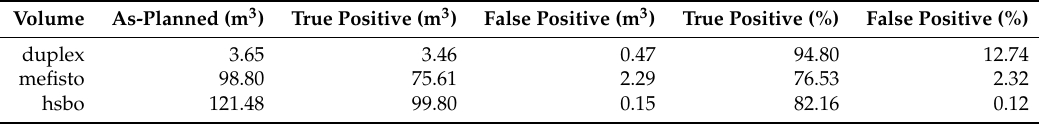
Table 1. Comparison of octree volumes for each evaluation